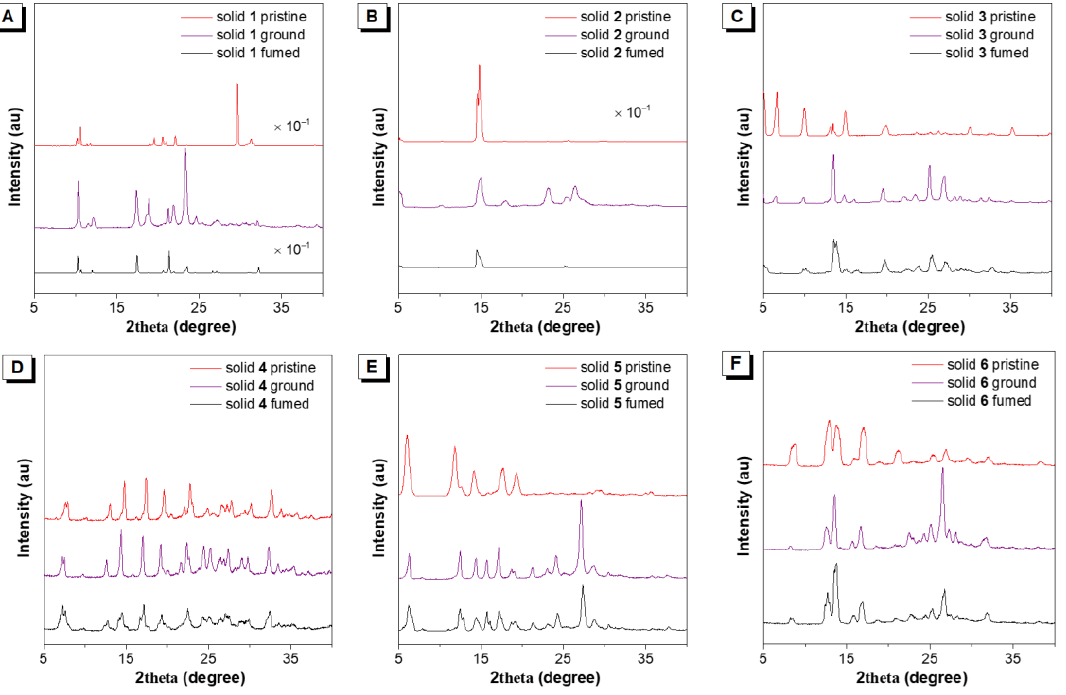
Figure 3. ( A – F ) The PXRD patterns of molecules 1 – 6 as the pristine, ground, and fumed solids. Frontier molecular orbitals were calculated at the B3LYP/6–311G* level by using density functional theory (DFT) to study their optical properties. As shown in Figure 4, although the DFT calculation showed compound 1 had no very clear separation of the highest occupied molecular orbital (HOMO) and the lowest unoccupied molecular orbital (LUMO), after careful analysis, we can see that the distribution of HOMO and LUMO is non-uniform in compound 1 . The electrons of HOMO are mainly located on the right segment of 1 , especially on the electron-donating diethylamino group. While the electrons in LUMO mainly resided on the left part. The electron cloud density of the phenyl ring in the box obviously enhanced, and the electrons on the diethylamino group decreased largely in LUMO. Thus, we think it existed a weak ICT transfer in compound 1 . The energy gap between the LUMO and the HOMO was calculated to be 3.585 eV. Molecules 2 and 5 have dipolar architectures due to the electron-withdrawing ability of cyano and nitro groups. The HOMO mainly centered on the electron-donating groups, but the LUMO lay on the cyanostilbene unit. The energy gap of 2 and 5 was 3.228 and 3.428 eV, respectively. For molecules 3 , 4, and 6 , the HOMO and LUMO resided on the whole molecule, and the energy gap was estimated to be 3.897, 3.764, and 3.610 eV, respectively. Among these AIEgens, 2 and 5 possessed a much smaller energy gap. Theoretically, they should have much redder emission. Actually, 2 and 5 emitted yellow fluorescence in powder, and the other molecules exhibited blue or green emission, which was in accordance with the calculation (Figure